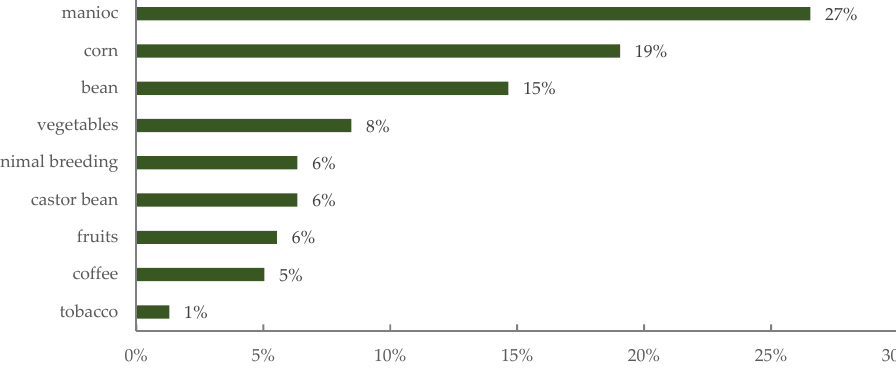
Figure 6. Main rural activities among the local farmers (Source: prepared by the authors).